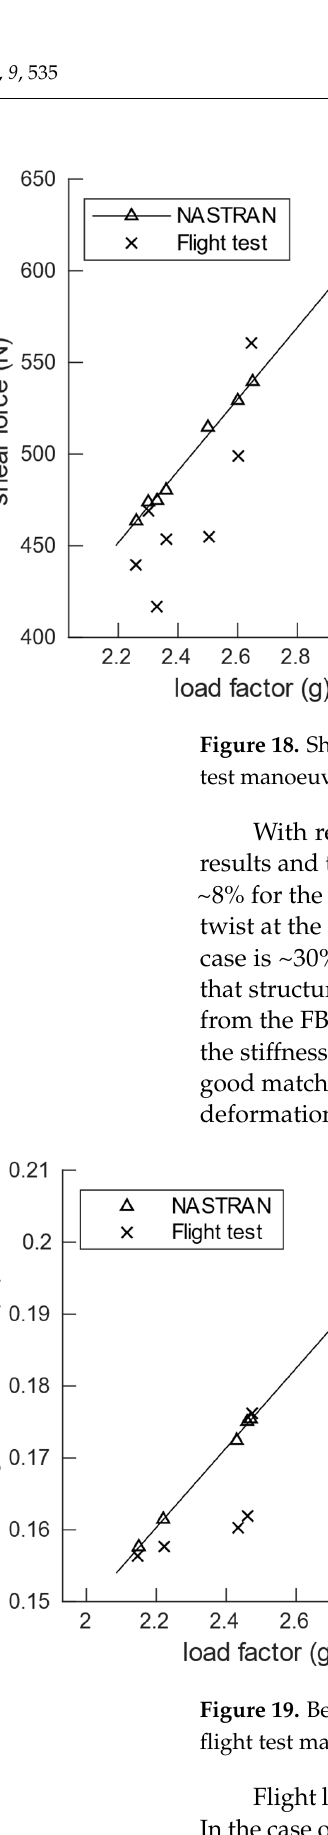
Figure 17. Bending and twist deformation (near wing tip—at spanwise location 2.95 m) at different flight test manoeuvres for the reference wing.